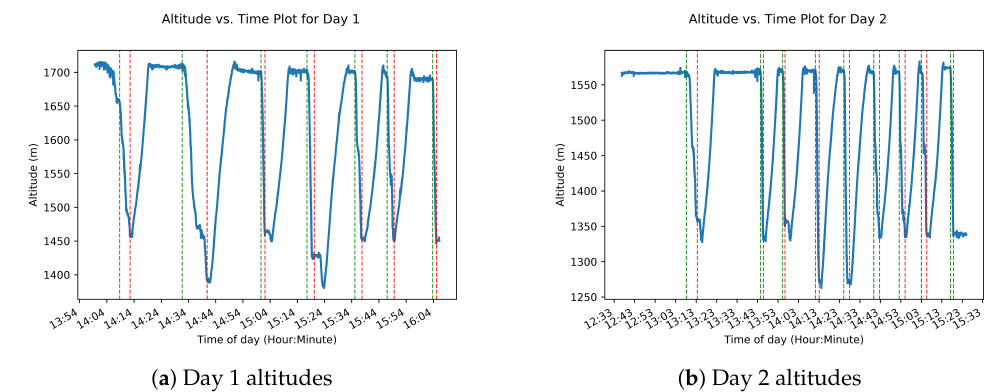
Figure 8. SkiMon altitude data over time. The dashed lines denote the start and end of runs, with green being starts and red being stops.